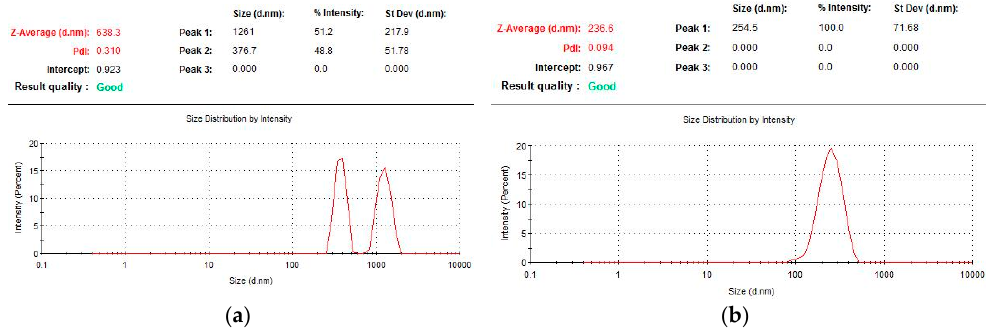
Figure 2. Particle size of HSA determined by photon correlation spectroscopy at various concentrations of cysteine: ( a ) 0.001 mg/mL and ( b ) 0.01 mg/mL. The characteristics of nanoparticles formed by varying the concentration of cysteine in the range of 0.001 to 0.5 mg/mL indicate that their optimal values are observed when the ratio of S–S bridges of the protein and the reducing agent is other than equimolar (Figure 2b). The cysteine concentration was more